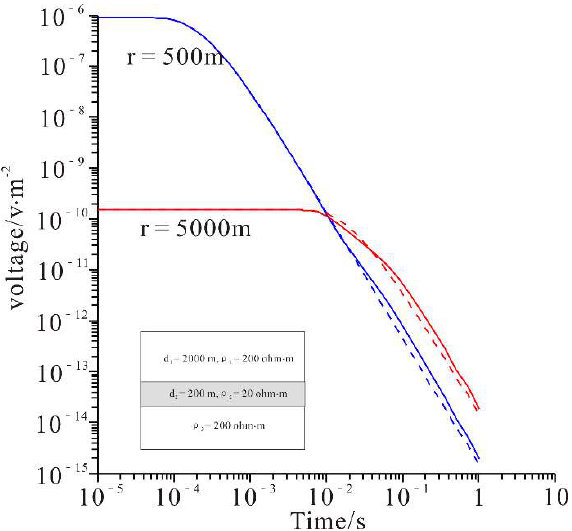
Figure 3. Comparison of responses of three-layer model and half-space model. The solid lines represent the three-layer model and the dashed lines represent the half-space model.